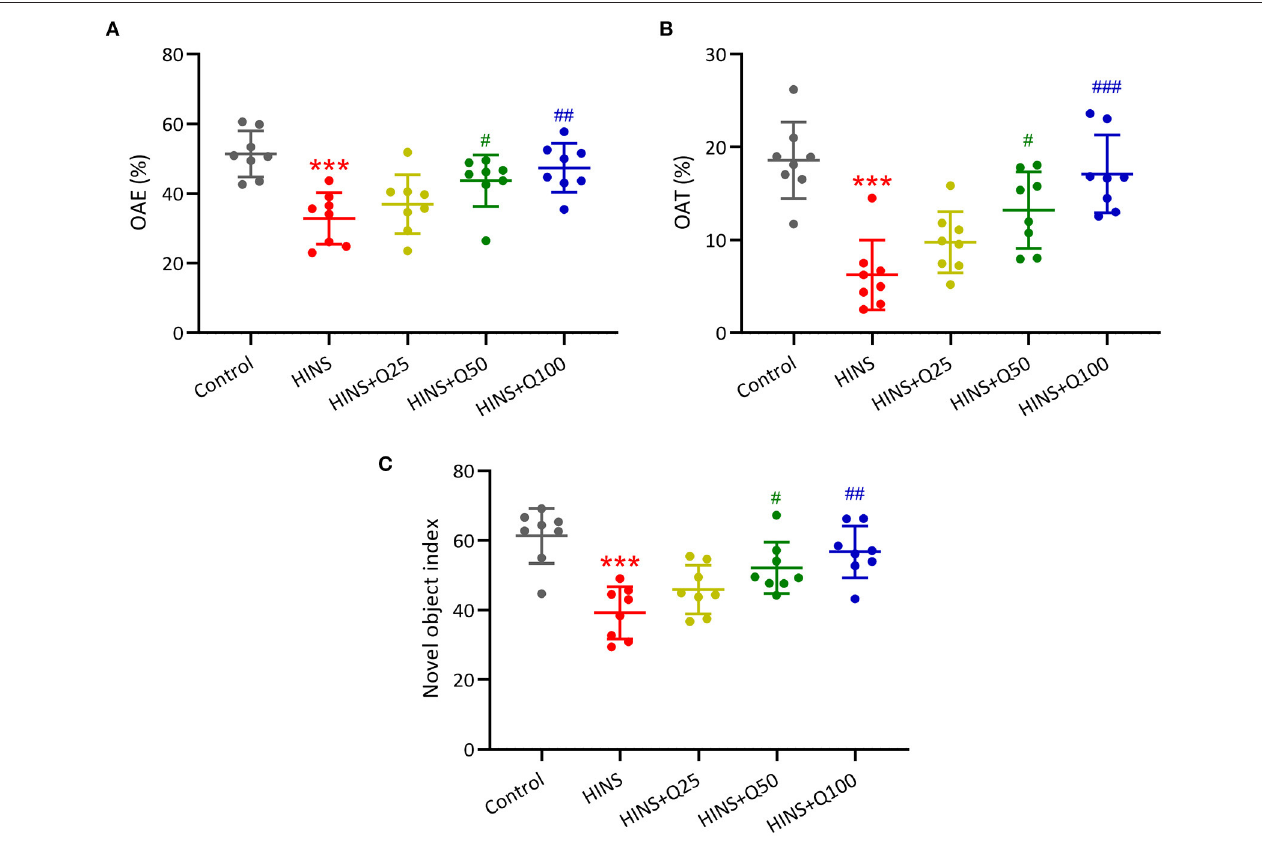
FIGURE 3 | Quercetin administration following HINS attenuated memory impairments of rats in novel object-recognition test (NOR) and elevated plus maze test (EPM). The percentage of OAE (A) and OAT (B) in EPM were recorded. (C) NOR was evaluated by calculating the novel object index. Eight rats were used to record in each group. Mean ± SD. *** p < 0.001 compared to control. # p < 0.05, ## p < 0.01, and ### p < 0.001 compared to